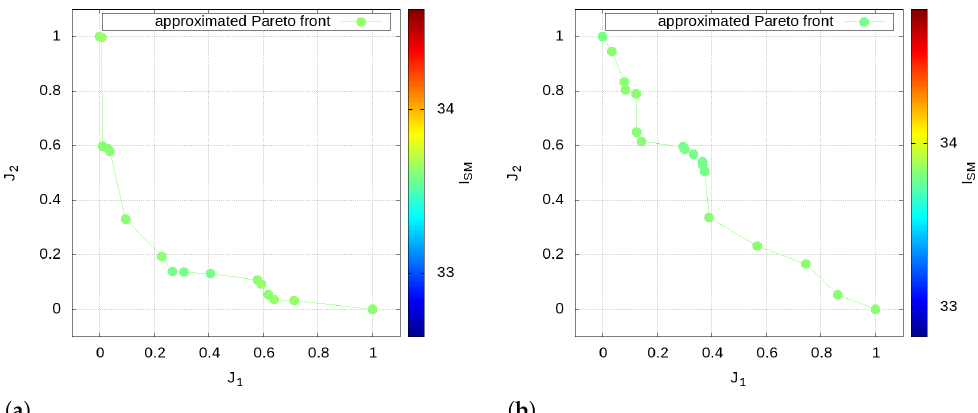
Figure 17. Solutions of the multiobjective problems for the approach operations: mapped approx- imated Pareto optimal solutions with the sound-matching index I SM as parameter. The solutions with the minimum I SM cannot be found. ( a ) single–aisle, ( b )